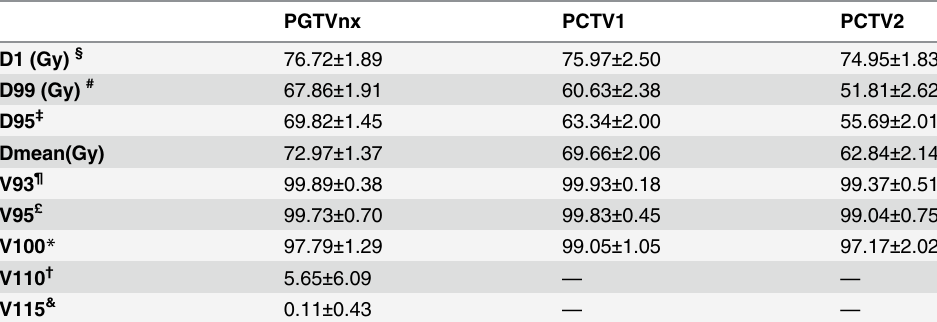
Table 2. Mean ( ± SD) of doses based on the planning tumor volume for the 205 patients treated with volume-modulated arc therapy Index.